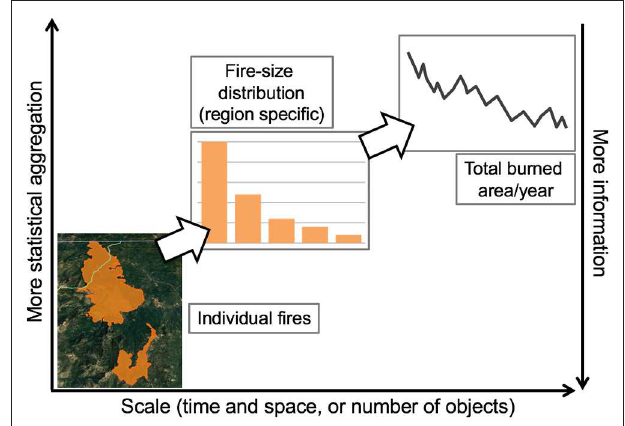
FIGURE 4 | Coarse-graining leads to useful metrics at the largest scales, but reduces the amount of event-specific information retained in each step of statistical aggregation. In this schematic example, coarse-graining applies to individual fires, where information such as location, perimeter, point of ignition, severity, topography, local temperatures, and other information are known. One first step of coarse-graining produces a fire-size distribution, where information on number of fires and area burned are known for some time period. At this level of coarse-graining, trends in aggregate properties of multiple fires are detectable, but still scale-dependent. A fire-size distribution emerges from a second step in coarse-graining, which maintains information about area burned for comparison over large time scales or large regions, but loses information about number of fires. The observed pattern in this second step will also depend on the spatial extent of the data. Other forms of coarse-graining, such as those employed in macroecology, will result in other emergent properties, some of which may be independent of